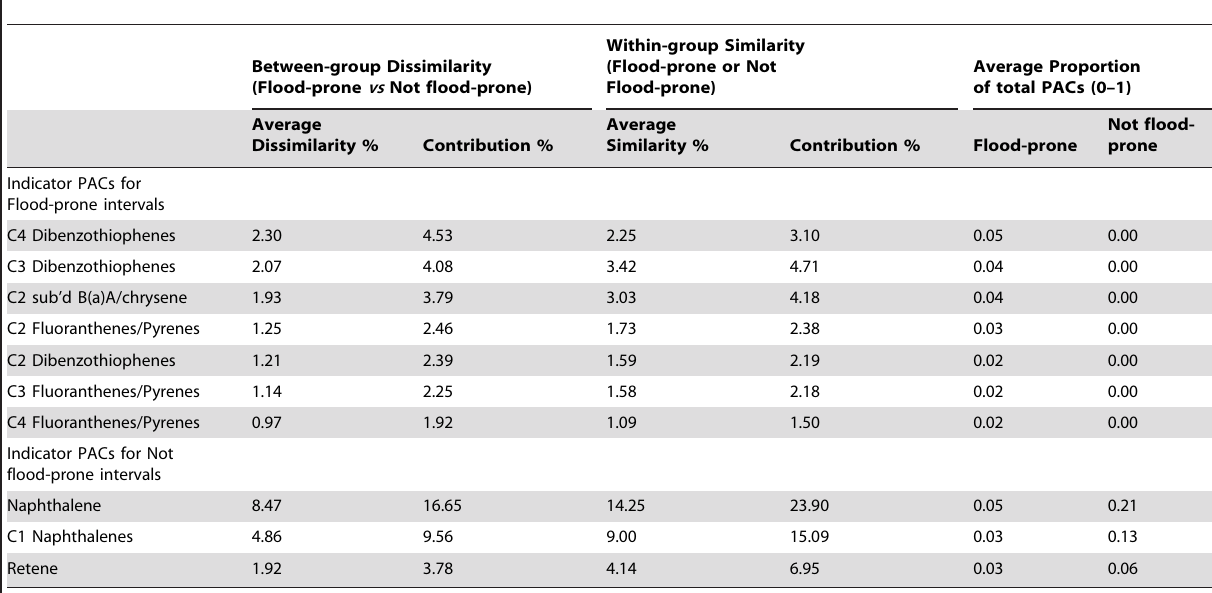
Table 1. Indicator PACs for flood-prone and not flood-prone